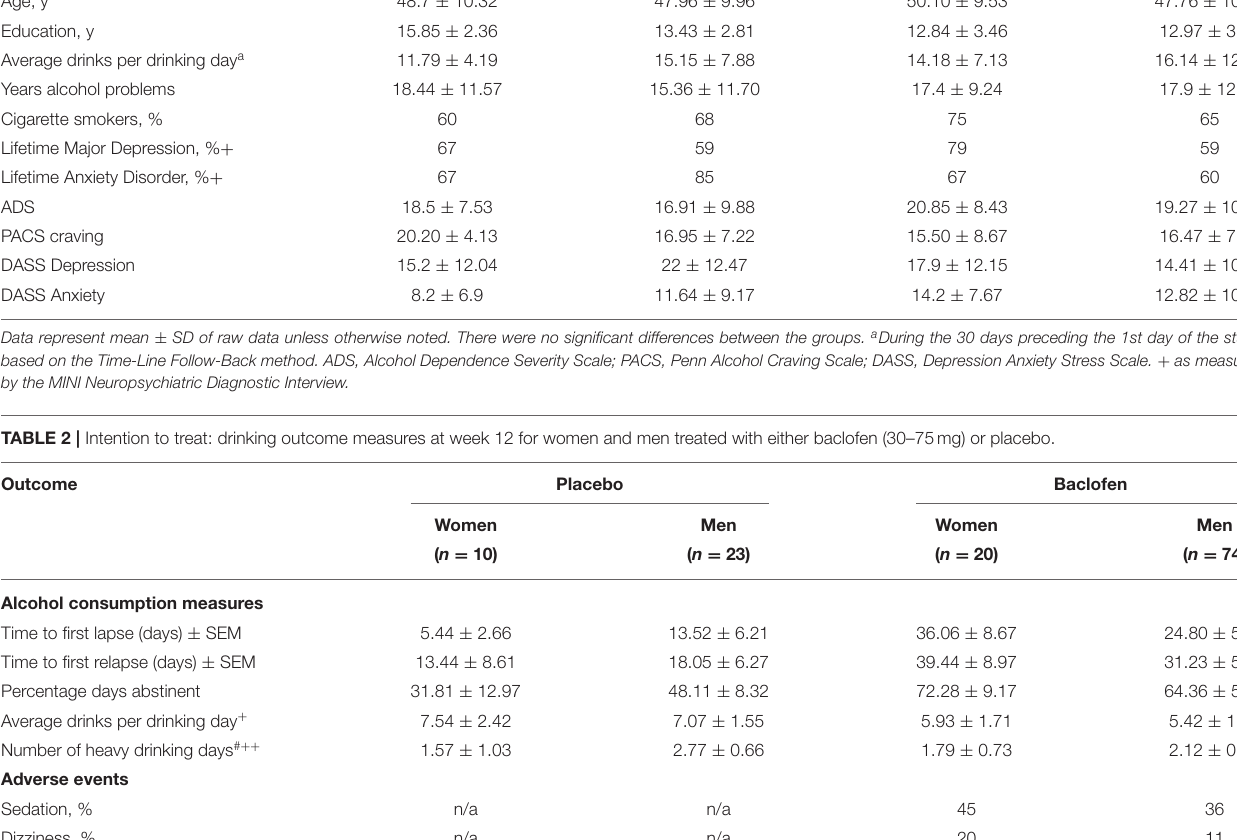
TABLE 1 | Intention to treat: baseline characteristics of patients according to sex and treatment. Placebo Baclofen Characteristic Women